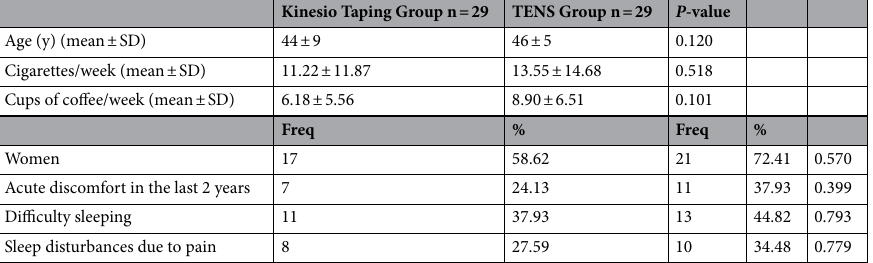
Outcome/group Baseline One month post-treatment Cohen’s d Within-group score change RMDQ (− 24)